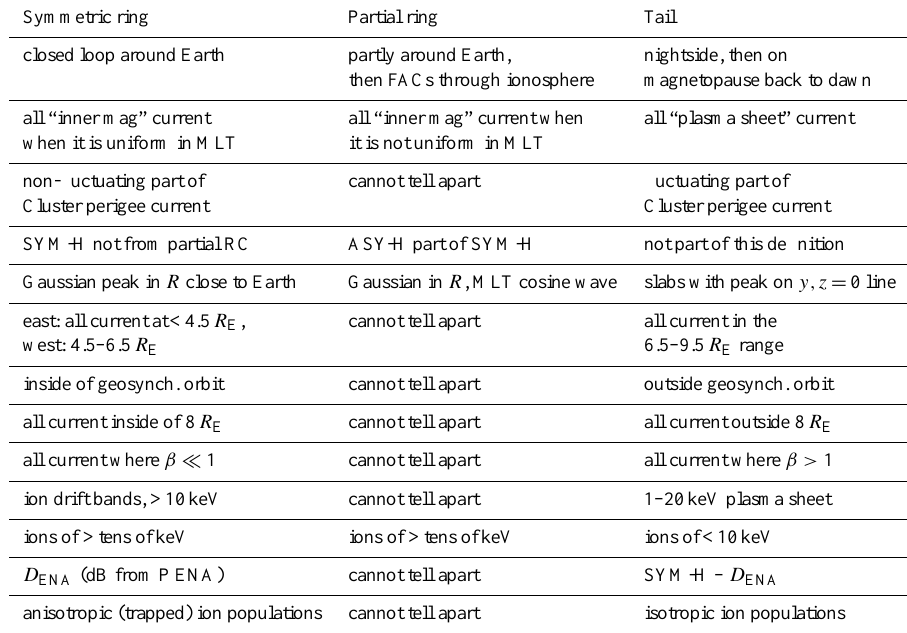
ions of >tens ofkeV cannot tell apart SYM-H – D ENA anisotropic (trapped) ion populations cannot tell apart isotropic ion